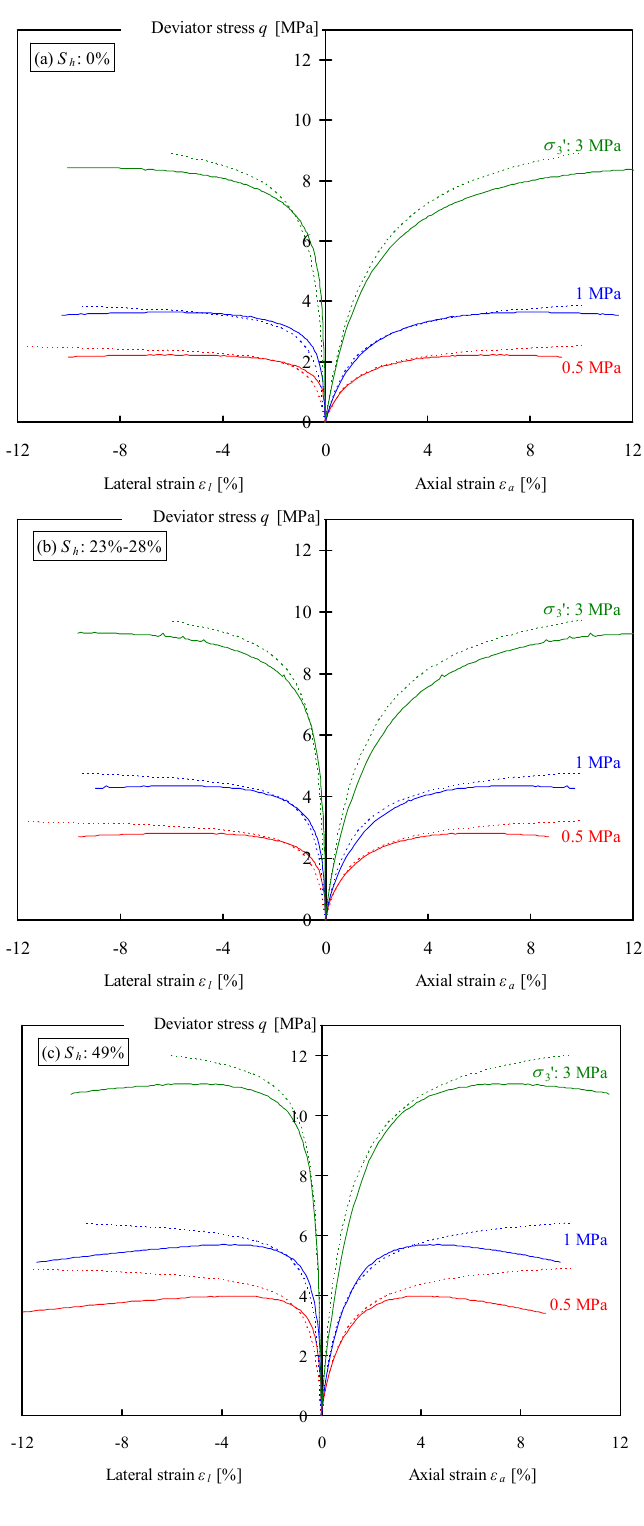
Figure 3. Experimental (solid lines) and calculated (broken lines) deviator stress q versus axial strain ε and lateral strain ε for specimens formed by No. 7 silica sand with methane a l hydrate saturation S of ( a ) 0%; ( b ) 23%–28% and ( c ) 49%. Experimental results are taken h from the reference